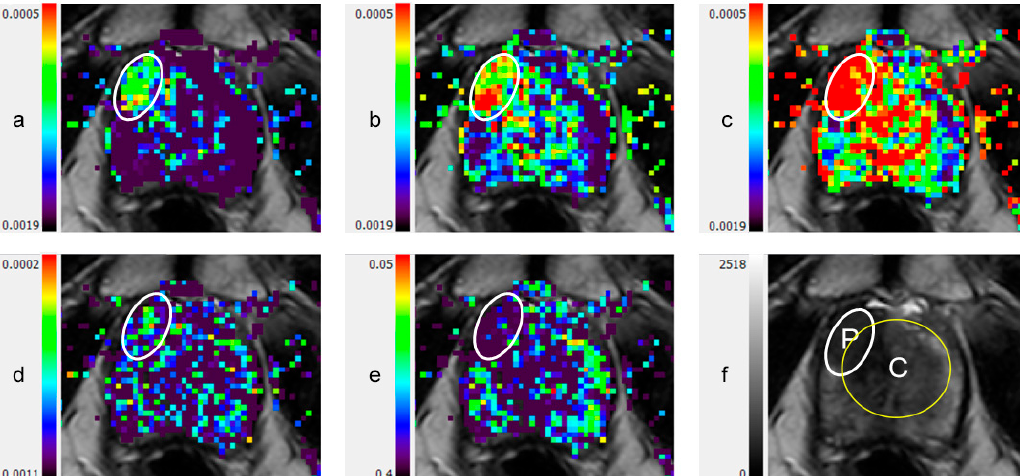
Figure 2. Anterior lesion involving peripheral zone and central gland, on color coded DTI maps and T2-weighted image: ( a ) λ 1 ; ( b ): λ 2 ; ( c ) λ 3 ; ( d ) maximal anisotropy (MA); ( e ) fractional anisotropy (FA); ( f ) T2-weighted image. C: central gland (transitional zone and central zone); DTI: diffusion tensor imaging; P: peripheral zone; White ellipsoid in ( a ) to ( e ): anterior lesion. Table 2. DTI and DWI metrics in normal prostate peripheral zone compared with central gland Parameter Peripheral Zone Central Gland * Mean Difference 2-Tailed Significance